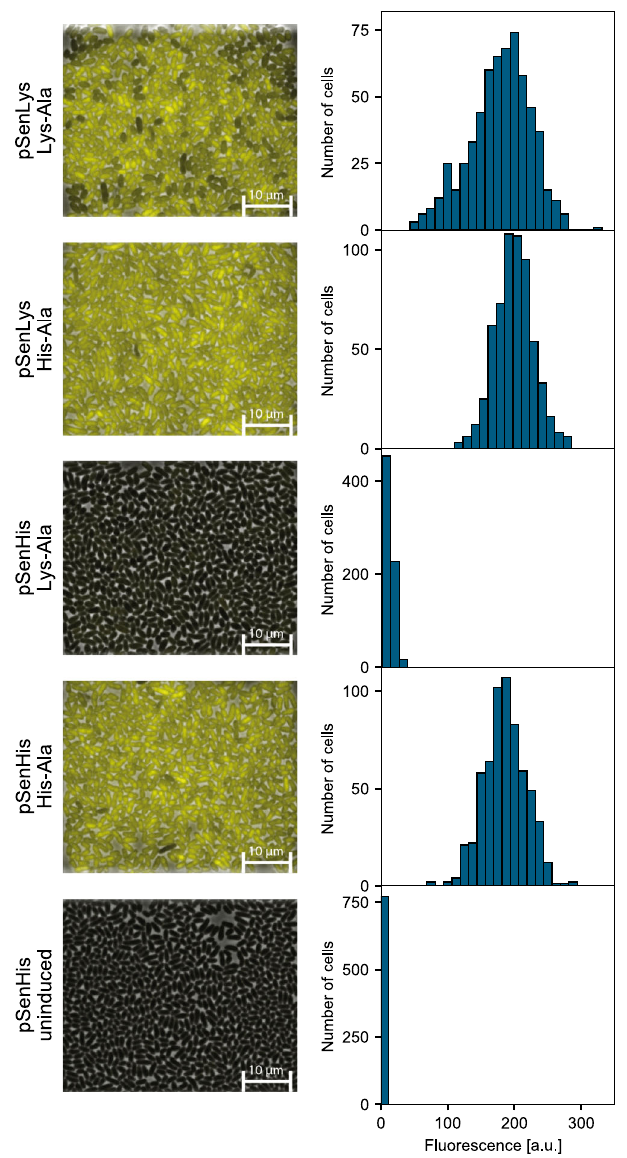
Fig. 3 Microscale cultivations of C . glutamicum Δ lysEG carrying pSenLys or pSenHis. At left: growth of cells in micro fl uidic chambers in the presence of L -His- L -Ala dipeptides, L -Lys- L -Ala dipeptides, or no dipeptides. At right: distribution of the corresponding fl uorescence as measure of the biosensor response at the single-cell level across